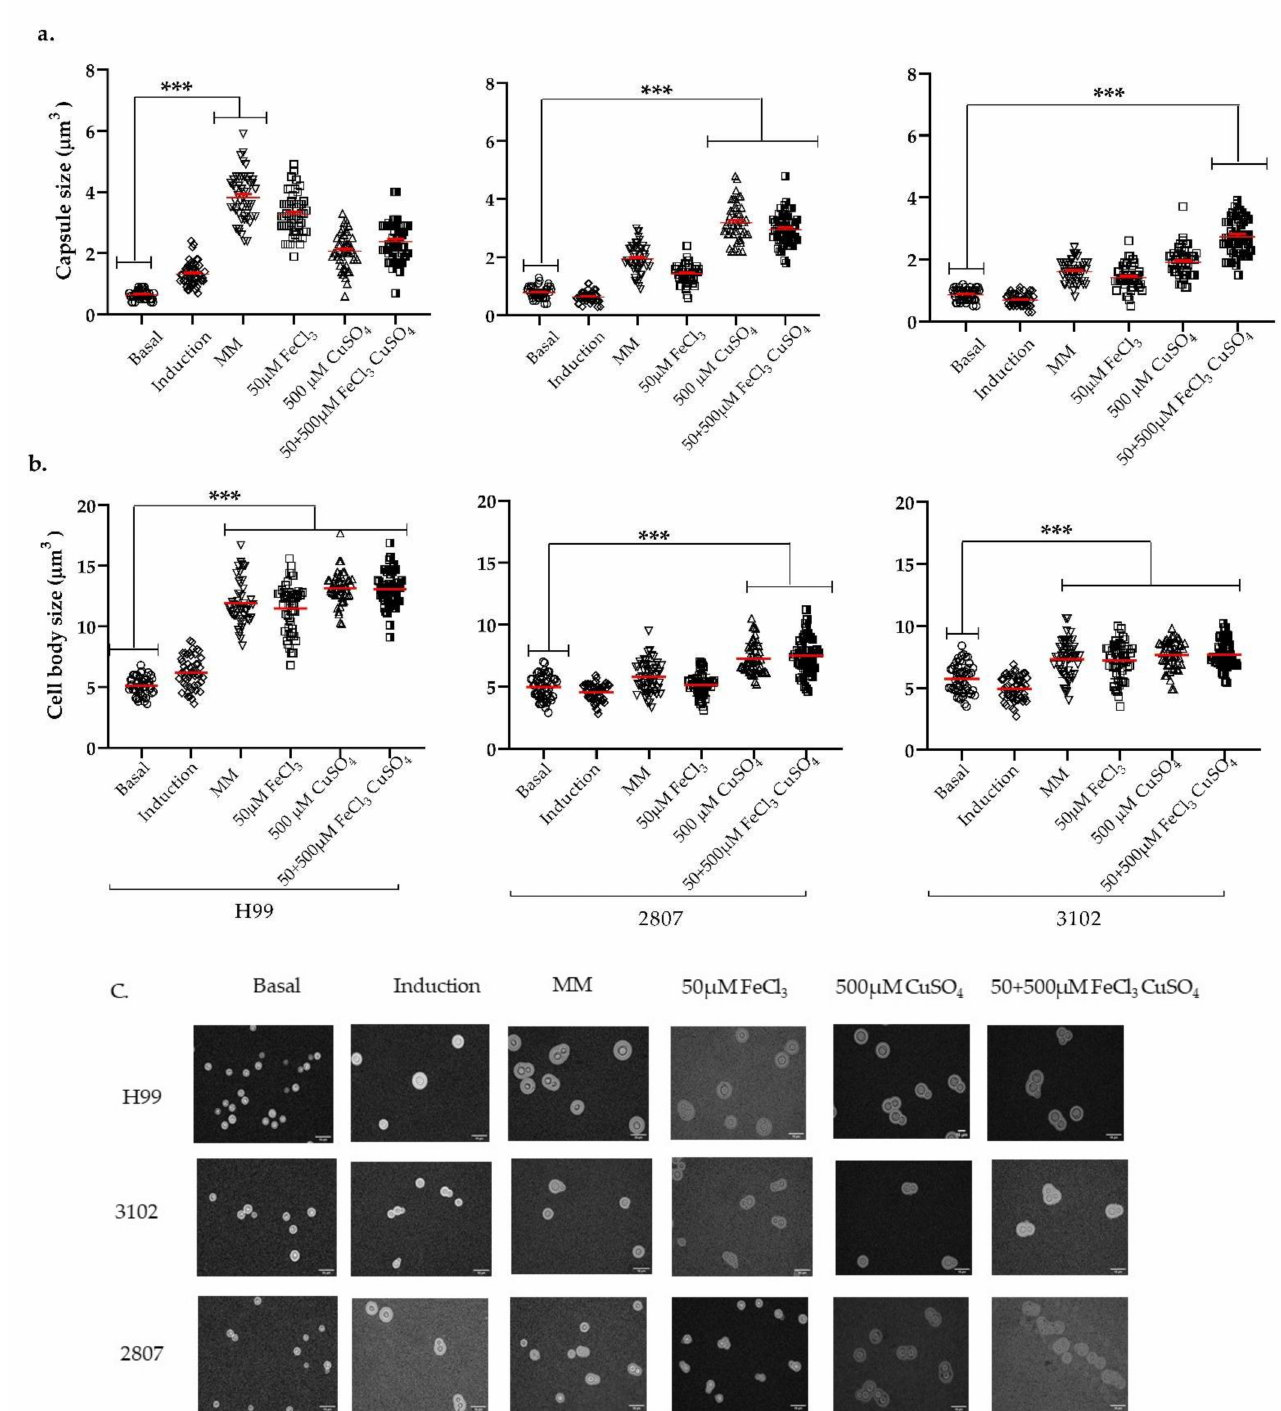
Figure 3. Distribution of the ( a ) capsular size, ( b ) cell size, and ( c ) photographic record of H99, 2807, and 3102. Different conditions were evaluated: basal (cell growth without capsule induction medium and without pre-incubation with metals), capsule induction (without pre-incubation with metals), MM (cell growth in capsule induction plus MM without metals), and 50 µ M iron, 500 µ M copper, and their combination (growth in capsule induction plus pre-incubation with the different concentrations of metals evaluated). The scale at the bottom right of the images represents 10 µ m. p ≤ 0.001 (***). The results correspond to three biological